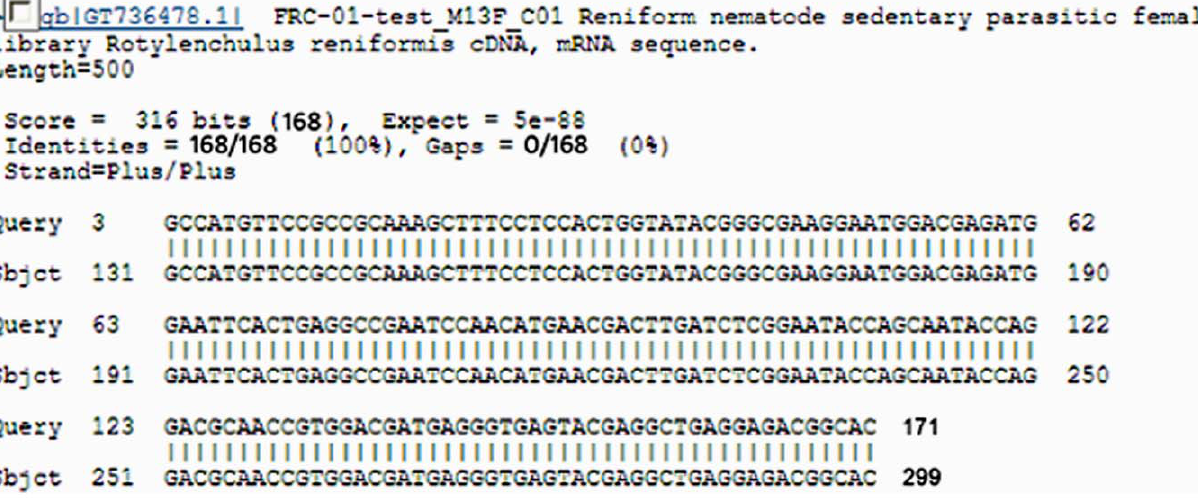
Figure 4. The Rr- b -TUB gene sequence obtained from DNA isolated from a qPCR reaction that was run on an agarose gel, gel extracted, cloned, sequenced and compared to Genbank matching accession